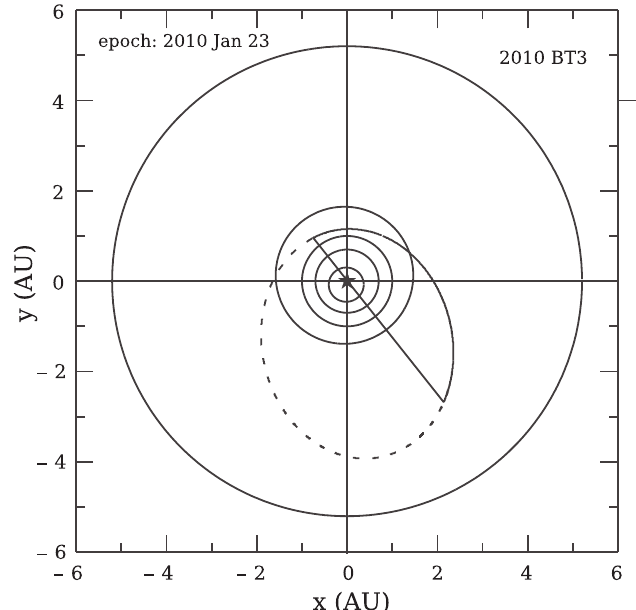
Fig. 2. The orbit of 2010 BT3 projected to the ecliptic plane, where the x-axis is directed to the vernal equinox.